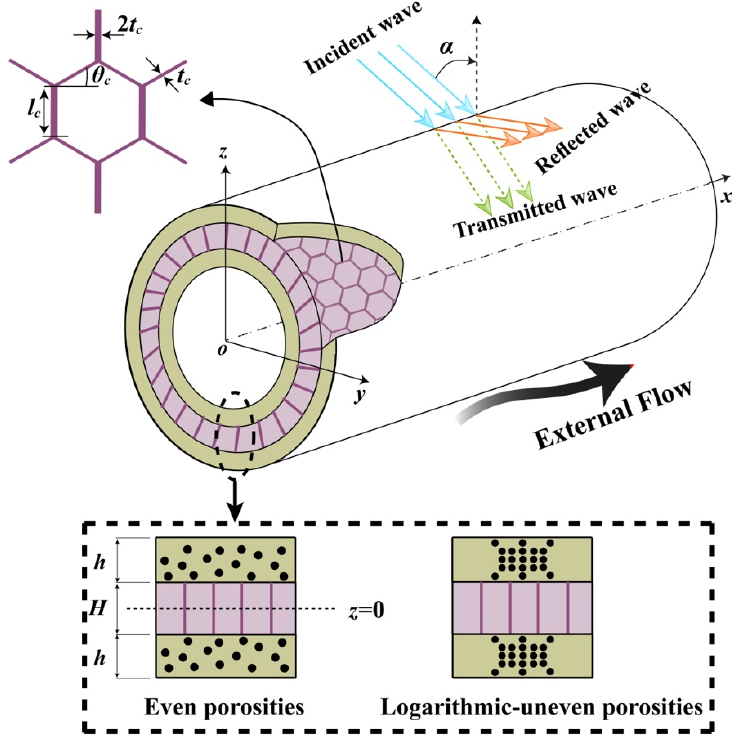
Figure 1. The schematic of a honeycomb sandwich cylindrical shell with FGP layers under incidence The schematic of a honeycomb sandwich cylindrical shell with FGP layers under wave. incidence